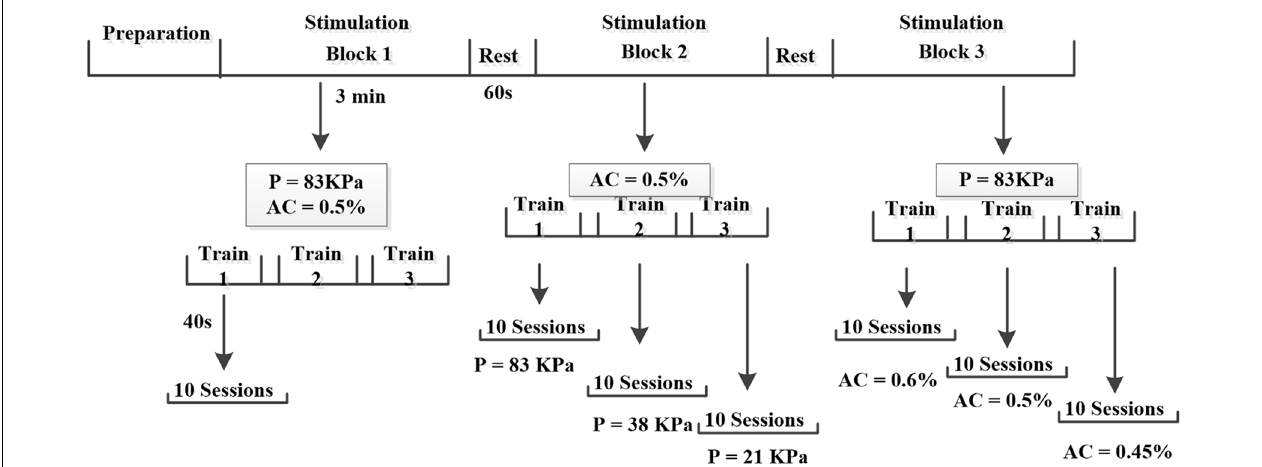
FIGURE 3 | Illustrate of experimental procedures. In the experiment, each mouse was stimulated by three blocks (constant Psptp and anesthetic concentration, different Psptp, different anesthetic concentration) and each block included three trains with 1 min interval. Each train lasted 40 s and 10 EMGs were collected. Furthermore, the preparation included the animal preparation, Psptp detection and pre-test. “P” means Psptp, “AC” means anesthetic